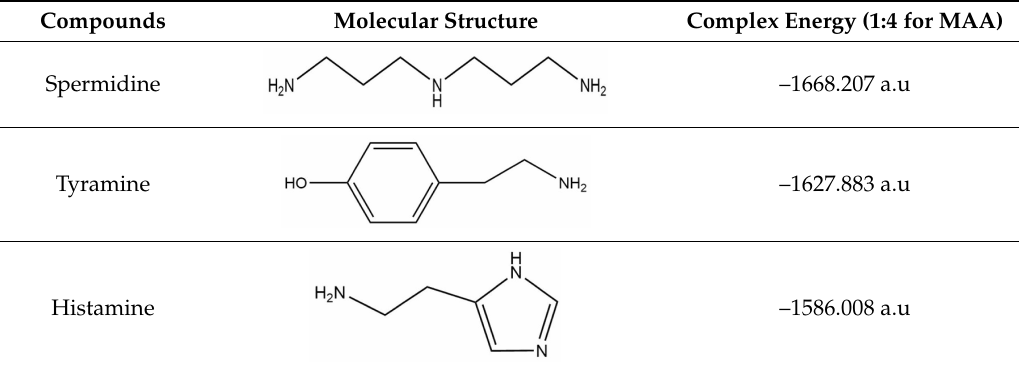
Table 7. The energy of three amine MAA